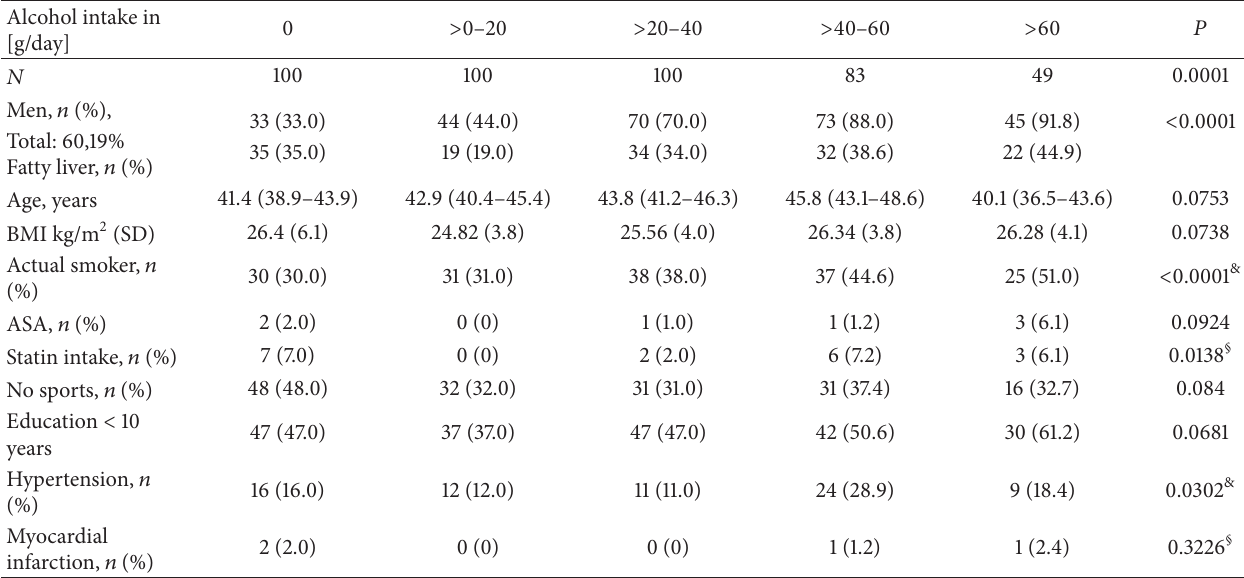
Table 1: Population characteristics ( § exact Fisher’s test; & with 0/1-coding of variables, 𝑃 for difference between